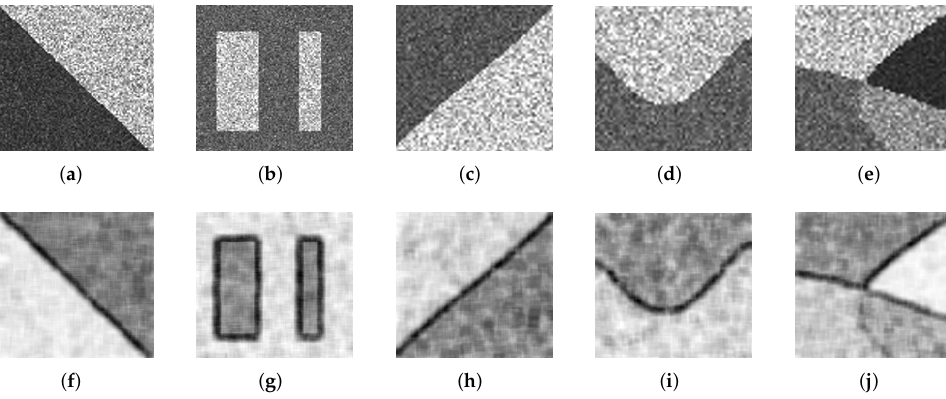
Figure 3. The results of dynamically balanced factor η i . ( a – e ) Five sample SAR image slices. ( f–j ) η i maps of ( a – e ),